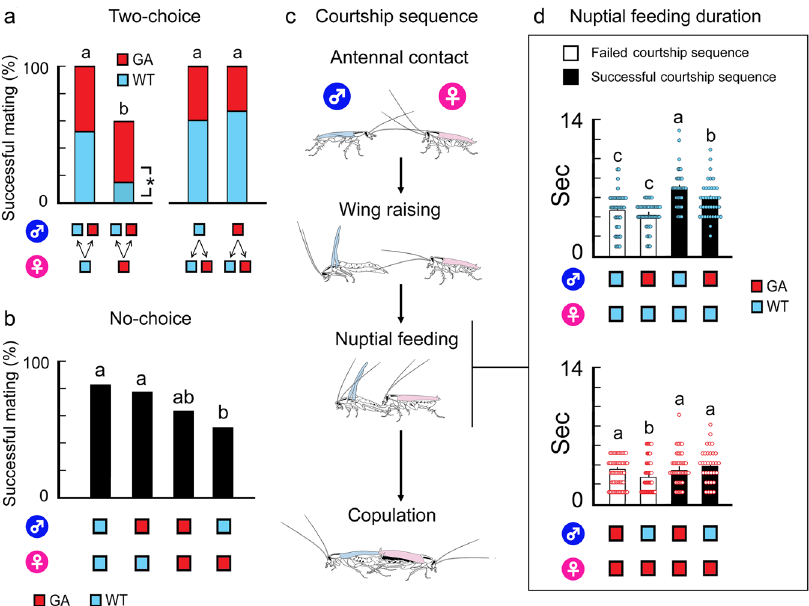
Fig. 1 Lower mating success of GA females is associated with short nuptial feeding. a Two-choice mating assay showing lower mating success in GA females. GA females experienced more courtship failures with WT males than with GA males. Different letters indicate signi fi cant differences in mating success ( χ 2 (3) = 29.50, P < 0.001). The asterisk indicates a signi fi cant difference in mating success of WT and GA males paired with GA females ( χ 2 (1) = 5.40, P = 0.020). b No-choice mating assays showing lower mating success in GA females than WT females. Different letters indicate signi fi cant differences in mating success ( χ 2 (3) = 16.70, P = 0.0008). c Courtship sequence of B. germanica , highlighting the importance of female nuptial feeding on the male ’ s tergal secretion (original drawings by A.W-K.). d Nuptial feeding duration (mean ± SE) is the time that a female spent exploring the male ’ s tergal gland with her mouthparts. The durations of failed and successful courtship sequences are indicated by white and black bars, respectively. Different letters indicate signi fi cant differences among treatments (ANOVA, Tukey ’ s HSD test, F (3, 167) = 18.97, P < 0.0001 (upper); F (3, 222) = 3.69, P = 0.01 (lower)). Short nuptial feeding duration causes failure to copulate in both WT and GA females and GA females had signi fi cantly shorter nuptial feeding than did WT females (Supplementary Table